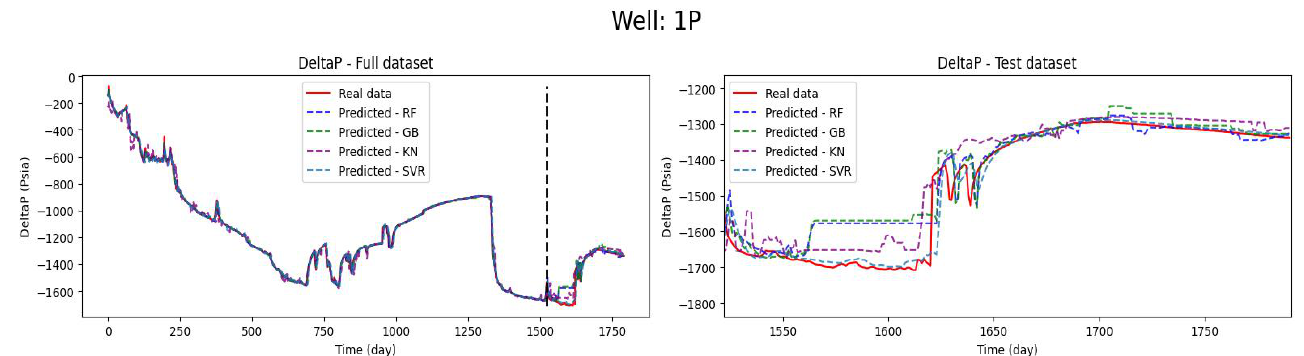
Figure 1 — The results in the full time range (Left) ;The results in the test dataset interval (Right). The vertical dash line represents the time where the dataset is splitted into 2 subsets: the training dataset is located to the left of the line whereas the test dataset is located to its